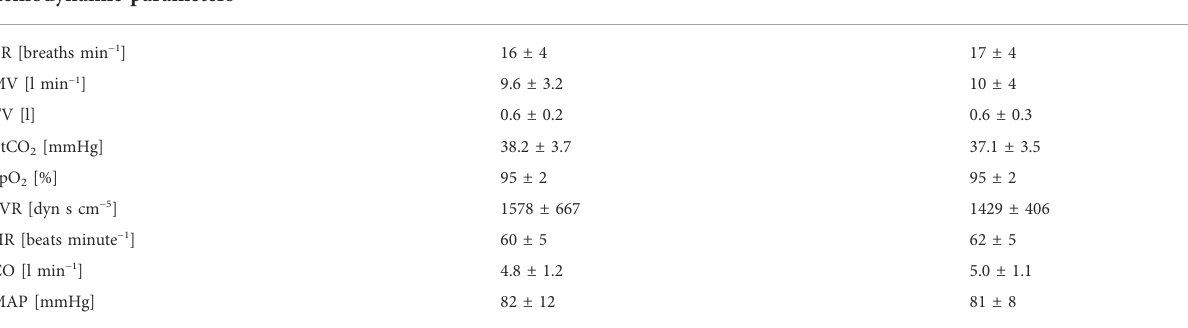
TABLE 2 Baseline ventilatory and hemodynamic indices. Baseline ventilatory and hemodynamic parameters